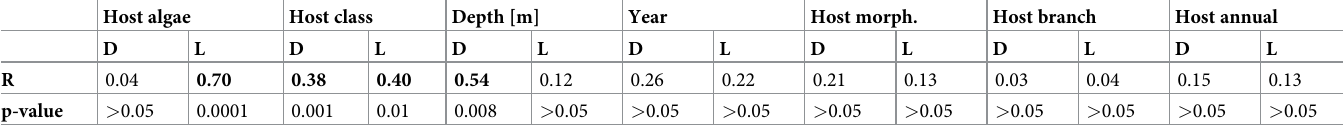
Table 5. ANOSIM test results performed on communities from Deception (DI) and Livingston Island (LI). Host algae Host class Depth [m]